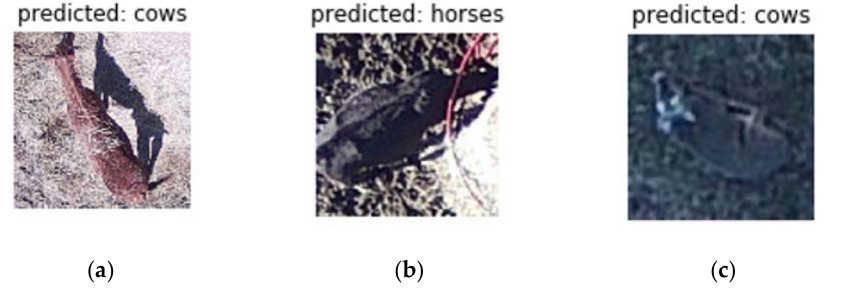
Figure 4. Examples of misclassified images of ( a ) a horse, ( b ) cattle, and ( c ) a white ‐ tailed deer.